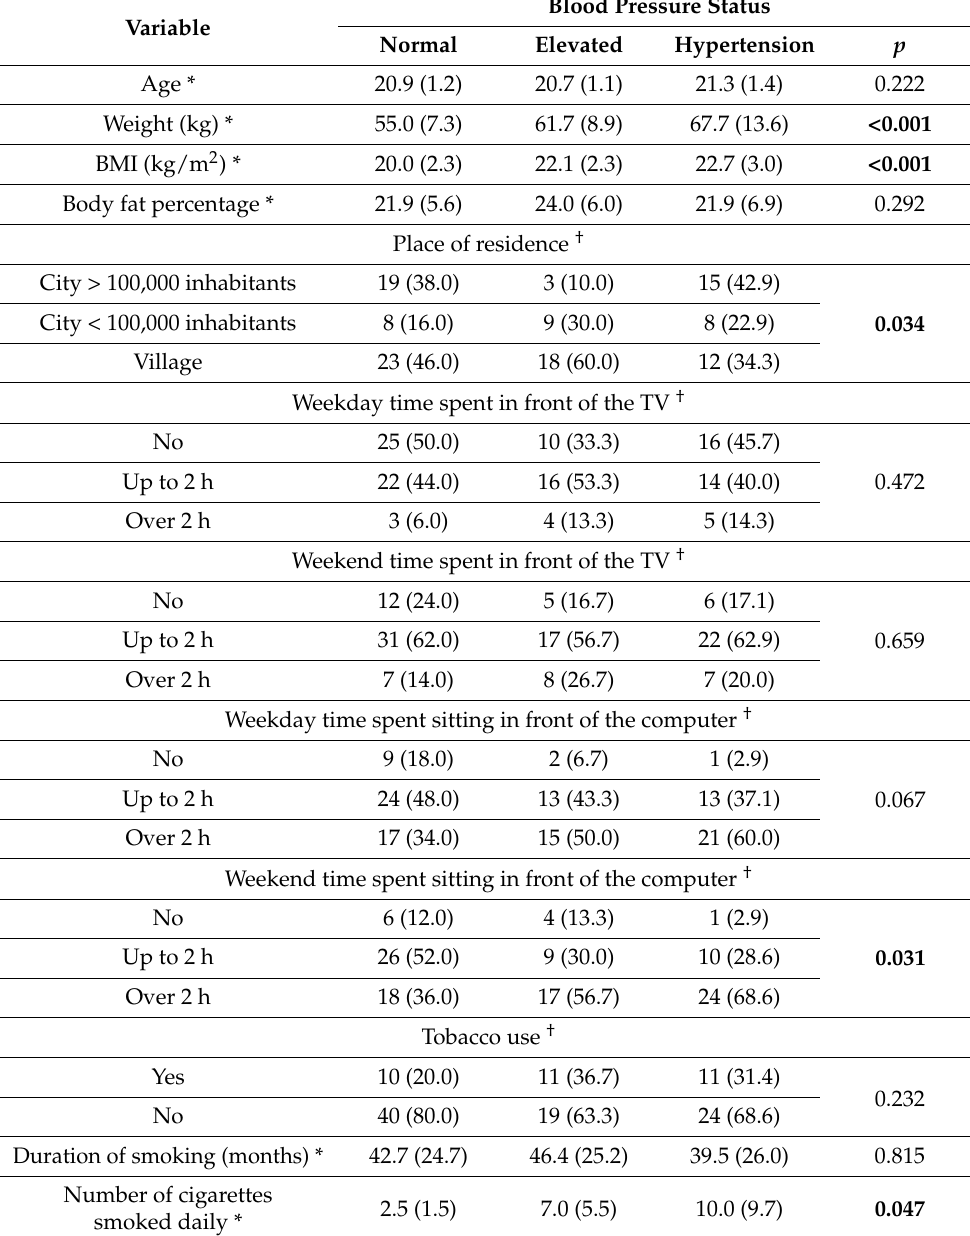
Table 3. Variables influencing the prevalence of